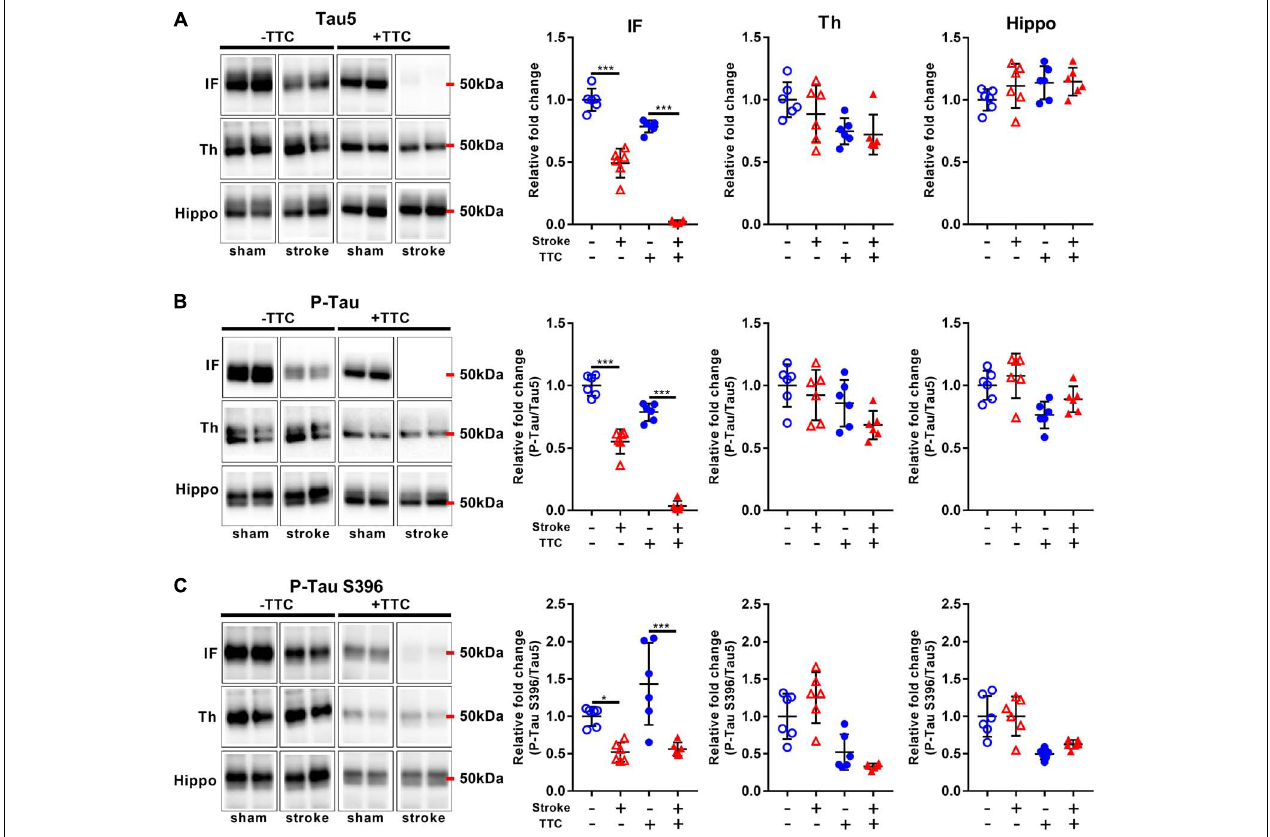
FIGURE 7 | Representative western blot and quantification of Tau5 (A) , P-Tau (B) , and P-Tau S396 (C) within the infarct (IF), thalamus (Th), and hippocampus (Hippo). Mean ± SEM (two-way ANOVA and Sidak’s multiple